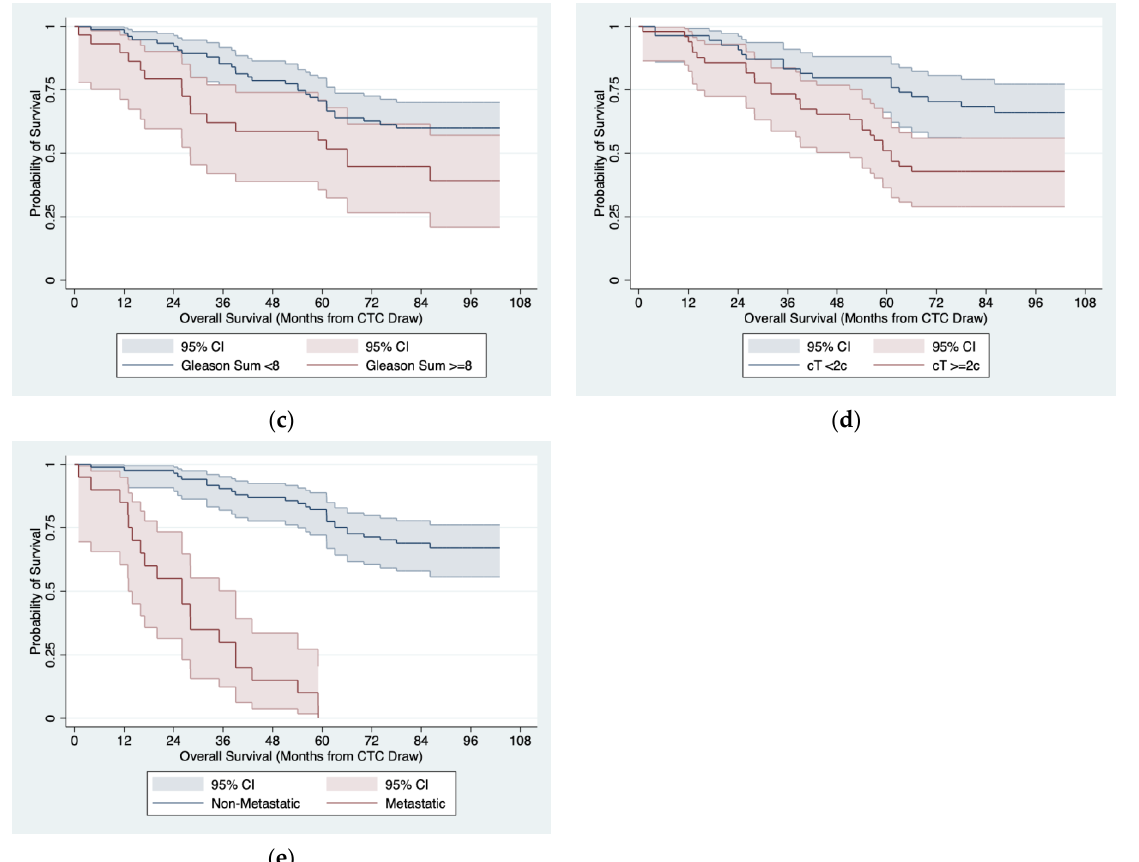
Figure 2. OS estimates in 104 high-risk PCa patients: ( a ) entire cohort; ( b ) by baseline CTC count ≥ 1 determined with the CellSearch ® system; ( c ) by baseline Gleason sum; ( d ) by baseline cT status; ( e ) by the presence of metastases at the baseline. Table 5. Univariate and multivariate analyses for OS in 104 patients with high-risk